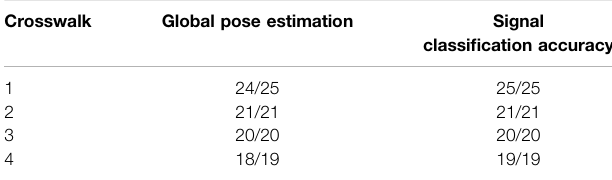
TABLE 4 | Four different crosswalks were used to test the system. Each trial had different start position and heading on texture plates.